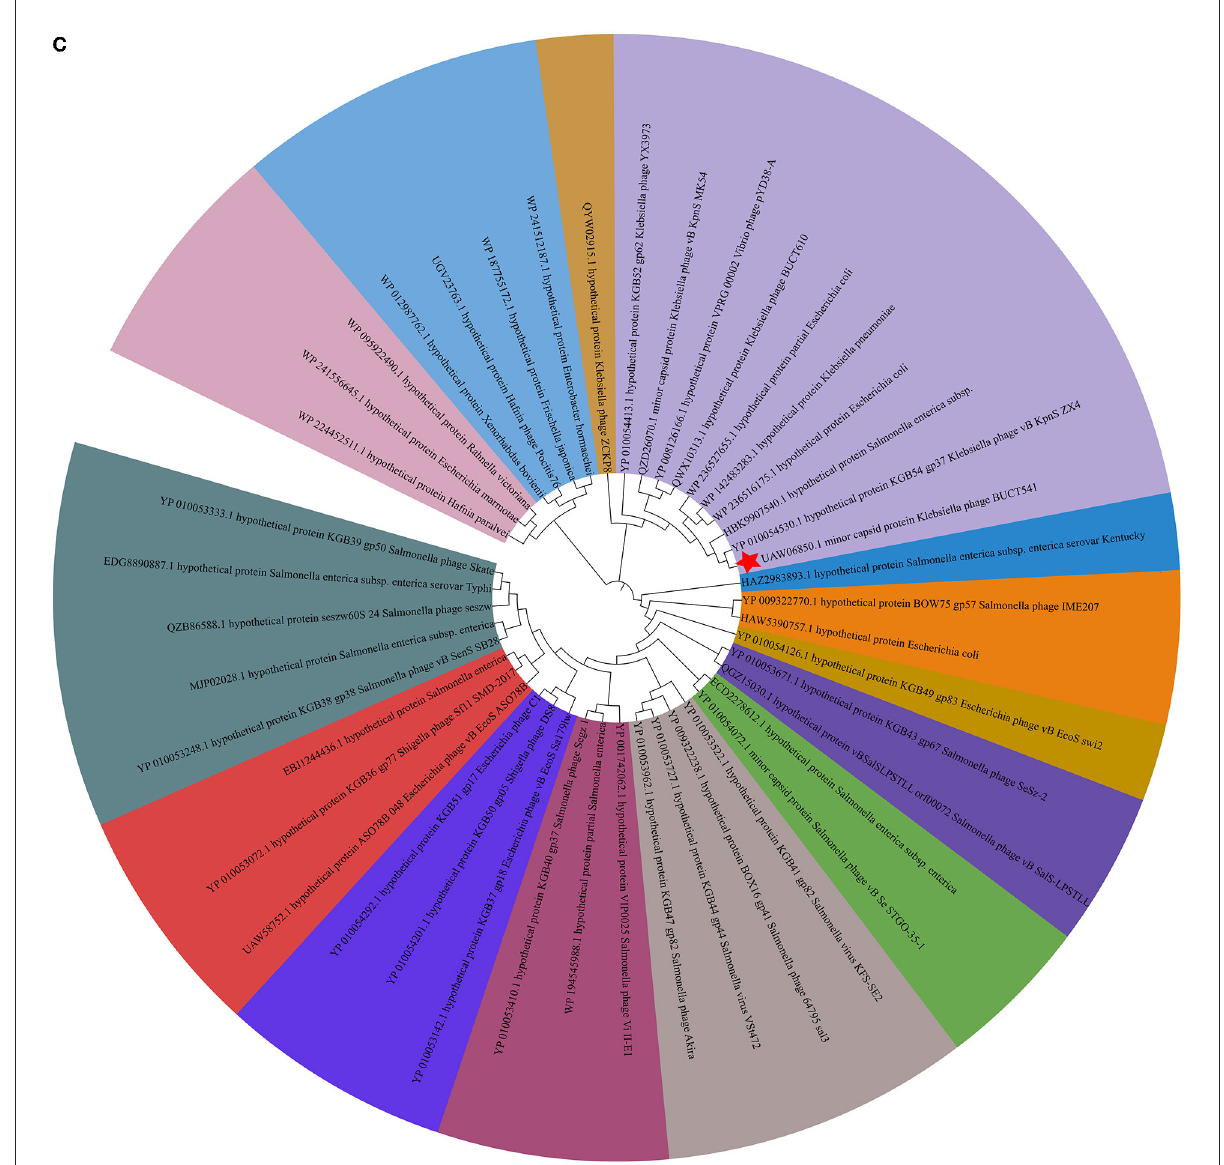
FIGURE5 (A) Phylogenetic relations of Klebsiella phage BUCT541 based on the whole genome sequence generated by VICTOR; (B) Neighbor-joining tree of Klebsiella phage BUCT541 compared to other phages available in GenBank based on the large terminase alignment of amino acid sequences; (C) Neighbor-joining tree of Klebsiella phage BUCT541 compared to other phages available in the GenBank based on the alignment of minor-capsid amino acid